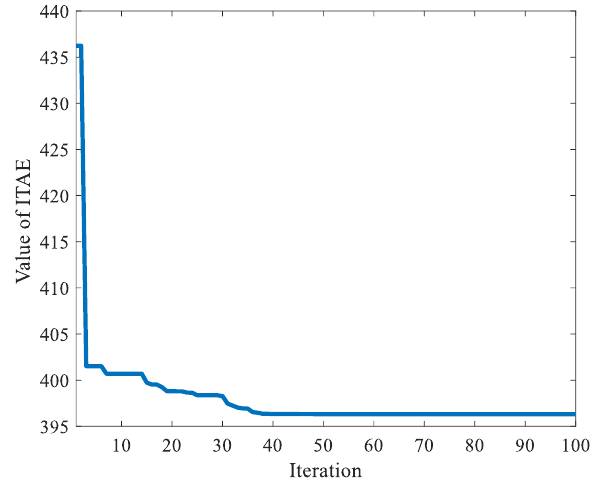
Figure 5. SO-based convergence profile for ITAE minimization